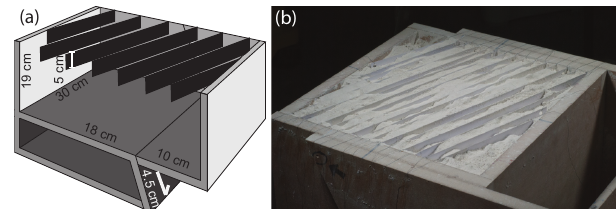
Figure 2. (a, b) Raw photo and deformation analysis of a joint in a hemihydrate powder pile created by impressing a blade. The pow- der is strongly affected. (c, d) Raw photo and deformation analysis of a joint in a hemihydrate powder pile created by sieving the pow- der around a sheet of paper and removing it afterwards (note the different scale bar for displacement). The removing-paper method proves to be the better